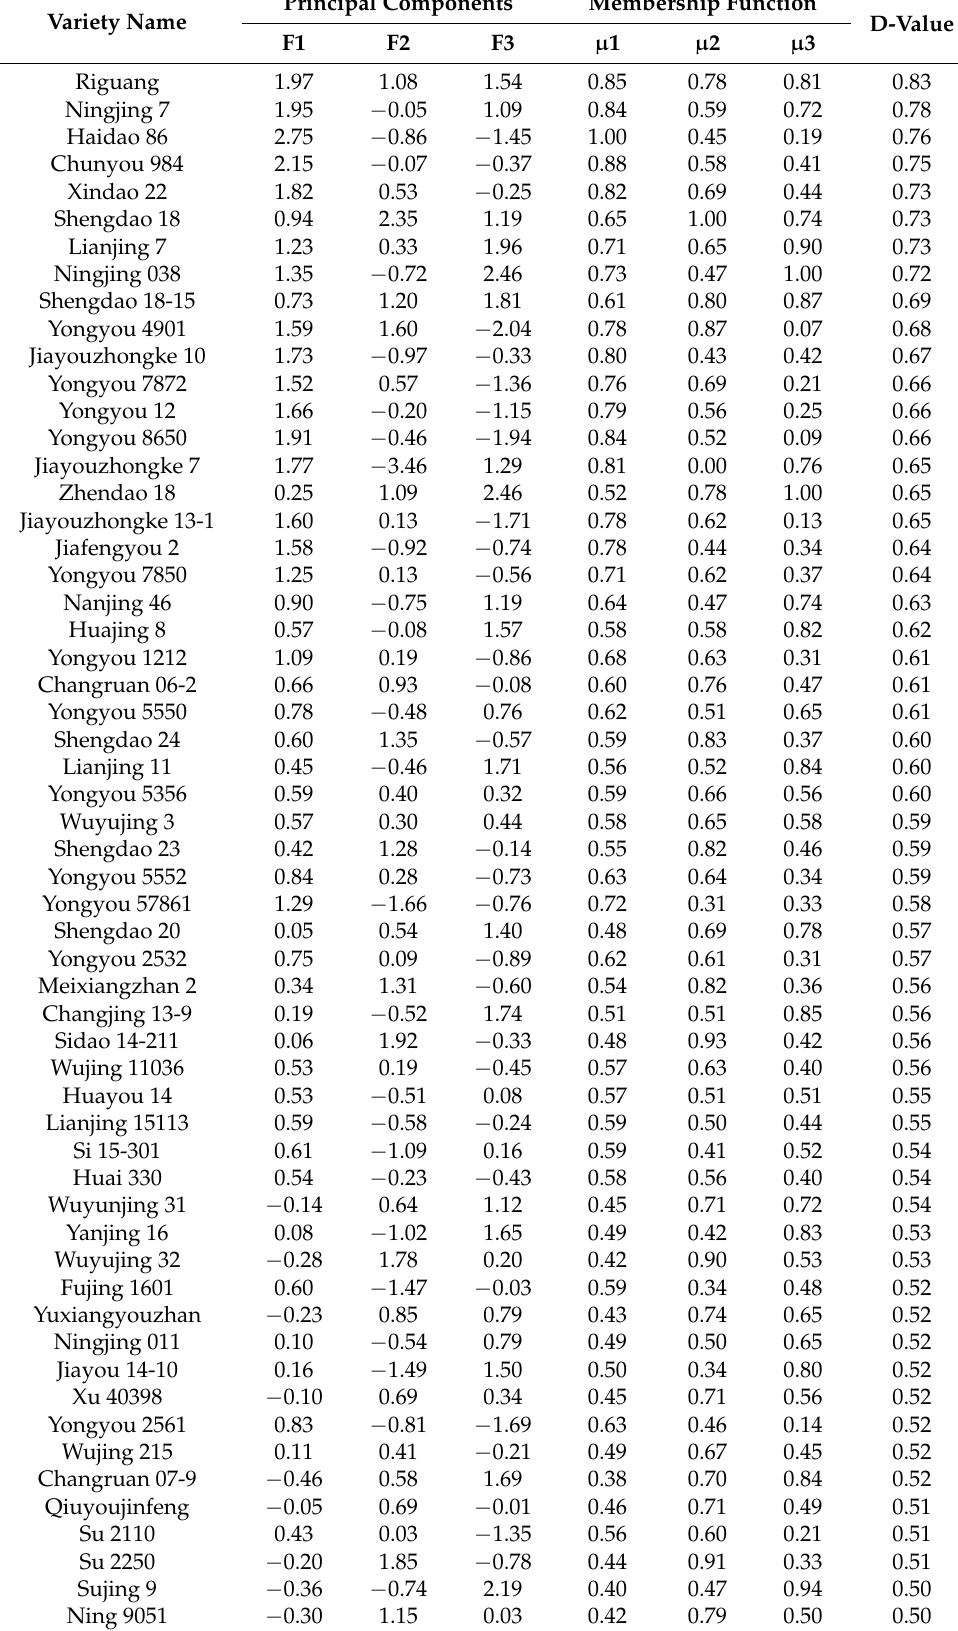
Table 2. Principal component value, membership function value, and D-value of each rice